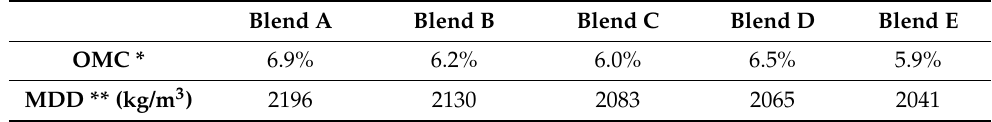
Table 3. Results from the modified Proctor test for all